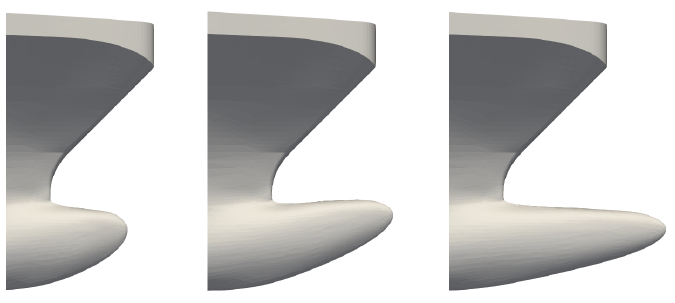
Figure 15. Bulbous bow shapes. Left: original shape. Middle: shape obtained at global minimum. Right: shape obtained at local